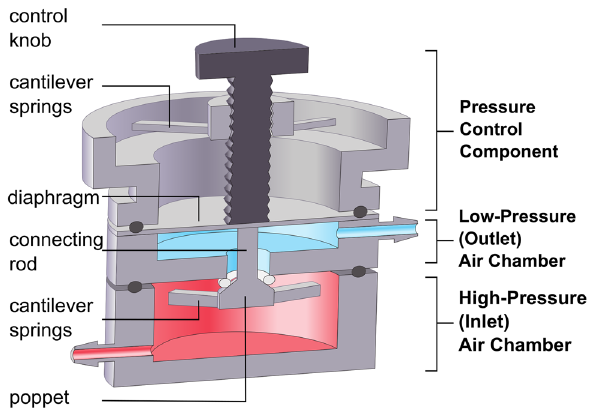
Figure 2. Cross-sectional schematic of essential components in the 3D-printed µPR. The high-pressure chamber (red) receives a constant high-pressure air supply from an external source. The low-pressure chamber (blue) outputs air at a constant low-pressure value. The outlet pressure is controlled by adjusting the pressure control component, consisting of cantilever springs and a control